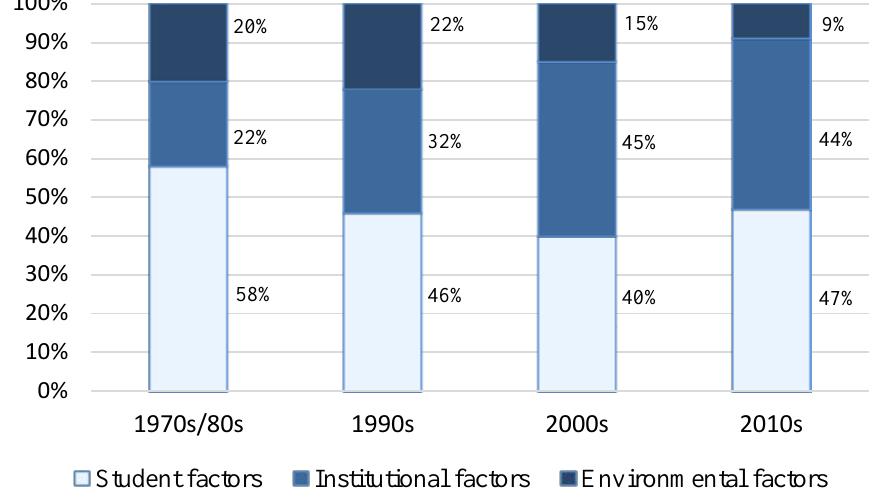
Figure 4. Proportion of the frequency of the three factor groups in various